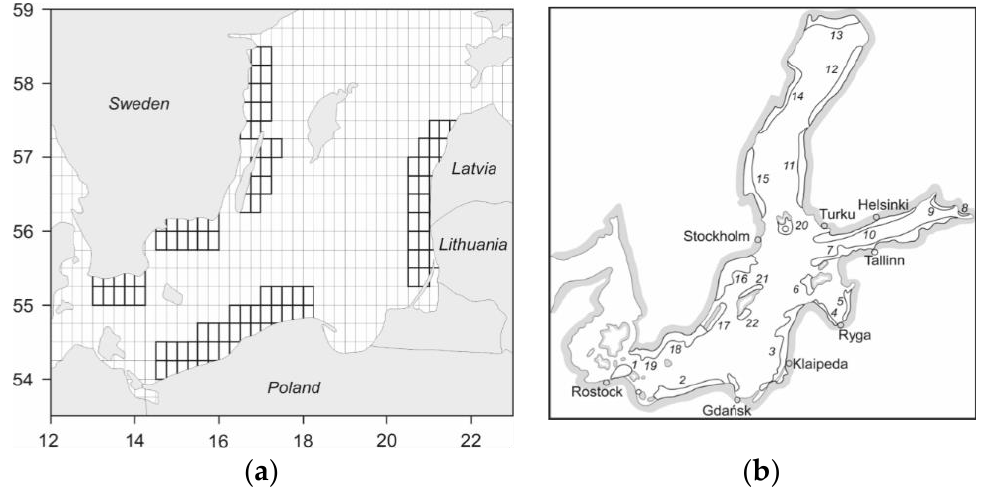
Figure 1. Area of the study with pixels taken into consideration computing sea surface temperature (SST) differences ( a ); main upwelling regions in the Baltic Sea (redrawn from Bychkova et al. [20]) ( b ).